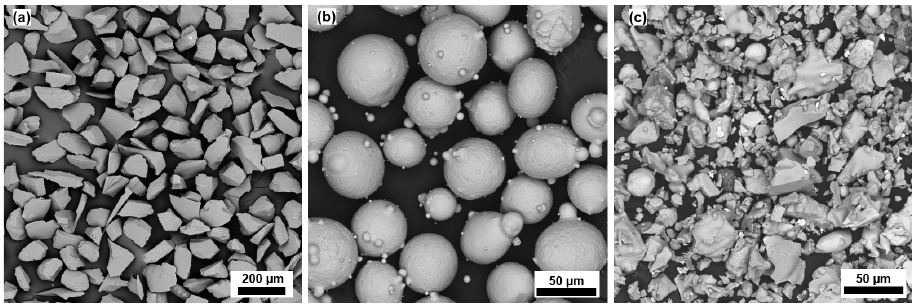
Figure 1. Micrographs of ( a ) SiC particles, ( b ) NiCrAlY powder, and ( c ) Cr 3 C 2 -25NiCr powder.